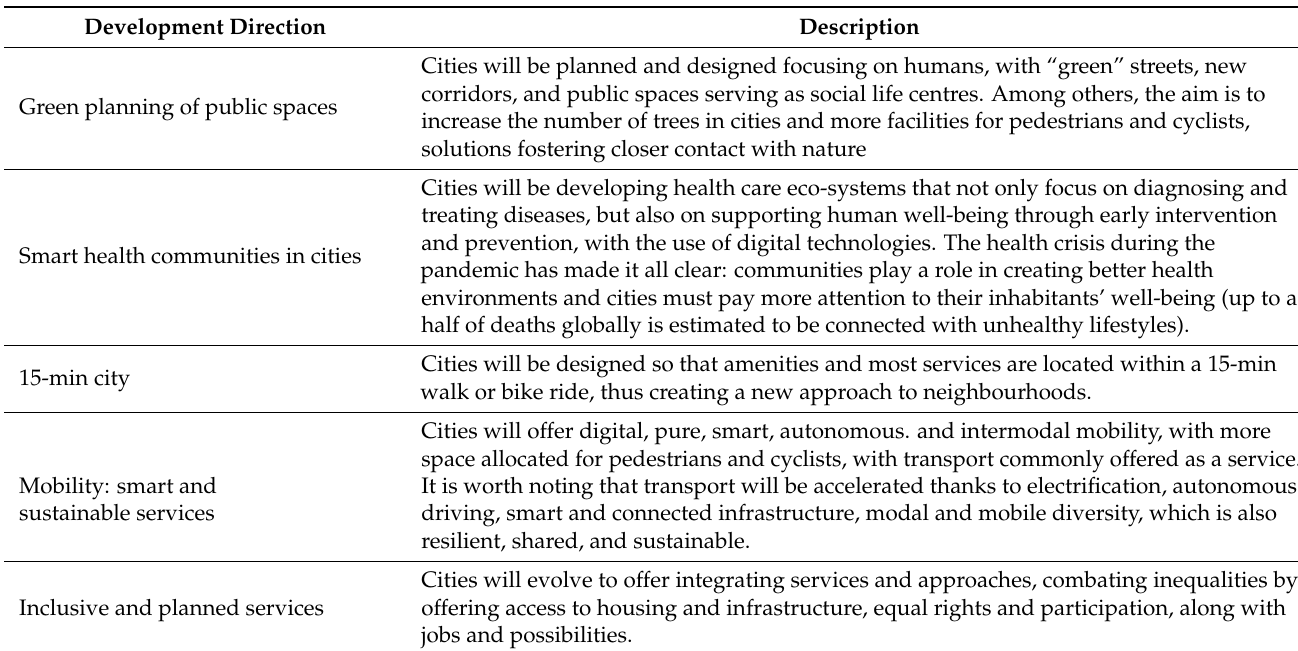
Table 6. A cumulative list of smart city development directions—Deloitte’s view